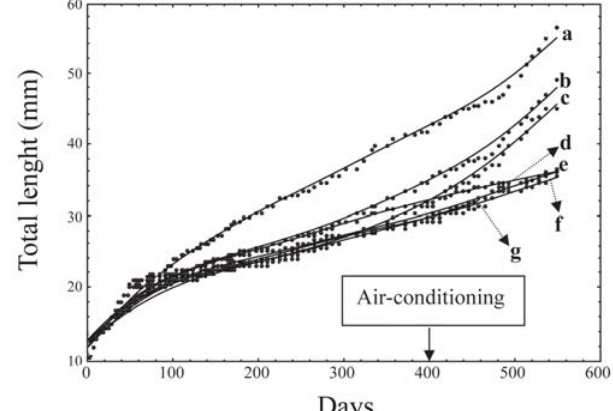
Fig. 1. (a) Reproductive adults of Ancistrus cryptophthalmus from Passa Três Cave kept in laboratory: two females (to the left) and male (to the right, dorso-posterior region of the head red-colored); arrow indicates the entrance of the shelter occupied by the male. Photograph taken on April 2004. (b) Cluster of eggs adhered to the ceiling of the shelter, average diameter = 4.0 mm. (c) Area around the shelter entrance (within the white circle) defended by the male (close to the center of the circle). (d) Clockwise from the top left: embrio (eyes visible), newly hatched larva (10.4 mm TL), more advanced larva (12.5 mm TL), with yolk-sac almost completely absorbed. (e) Top: 53 mm long juvenile from Passa Três Cave, with regressed eyes; arrow indicates the orbit reduced to a small depression covered with skin. Bottom: 53 mm long juvenile from Angélica Cave, probable the same age as the former, showing non-regressed eyes. (f) Detail of the head of the juvenile from Passa Três; arrows indicate the first primordia of tentacles.